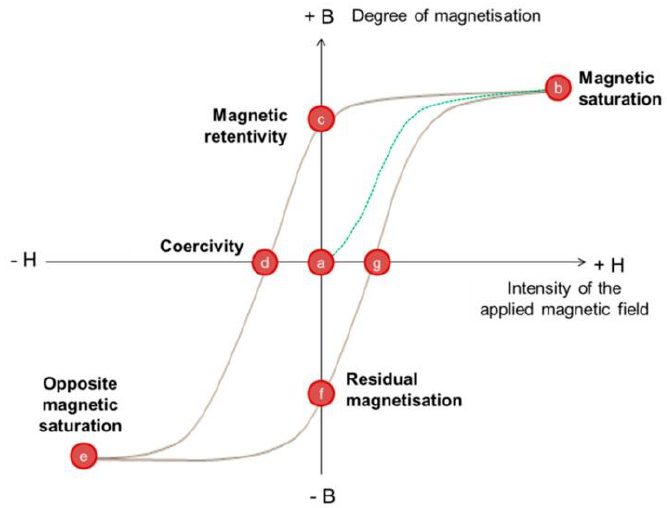
Figure 2. Hysteresis loop of a typical ferrimagnetism [27].